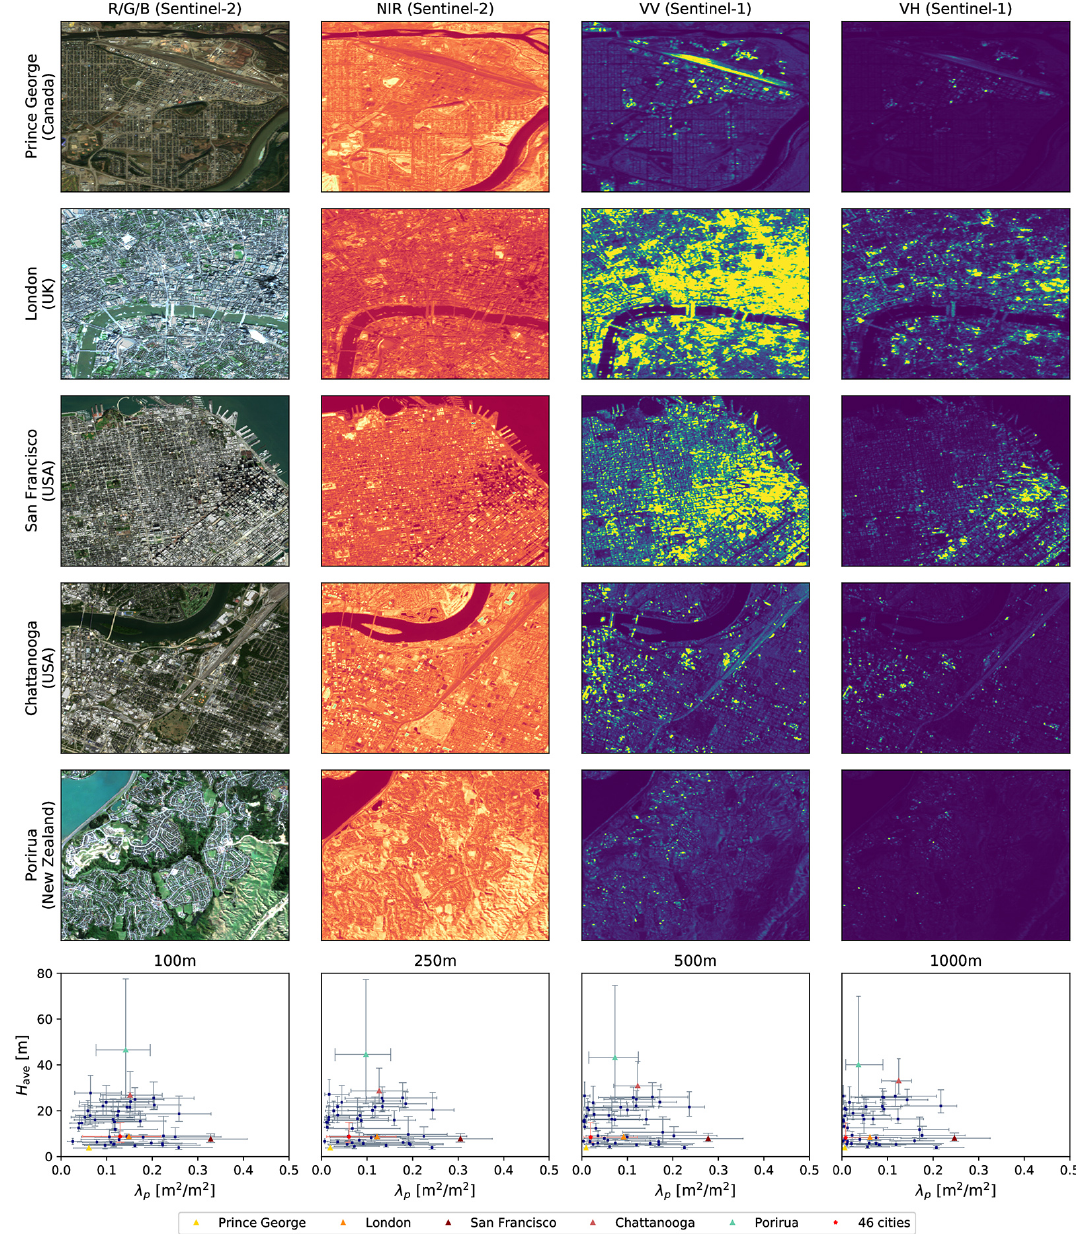
Figure 2. Top: Sentinel’s images of five representative cities where band values are shown in their annual medians and reference building layers are overlaid on the R/G/B bands of Sentinel-2’s images. Bottom: reference distributions of H ave and λ p in 46 individual cities and overall dataset D where each pair of vertical and horizontal lines are characterized by upper, lower bounds and middle points which represent the quartiles of the distributions of H ave and λ p ,